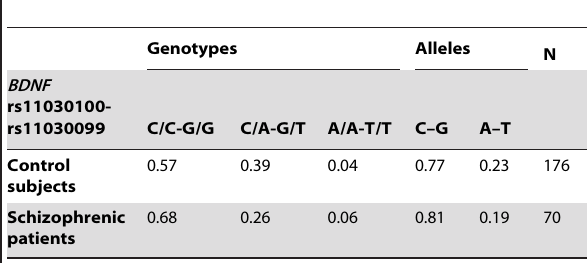
Table 3. Allele and genotype frequencies of BDNF polymorphisms rs11030100-rs11030099 in control subjects and schizophrenic patients.